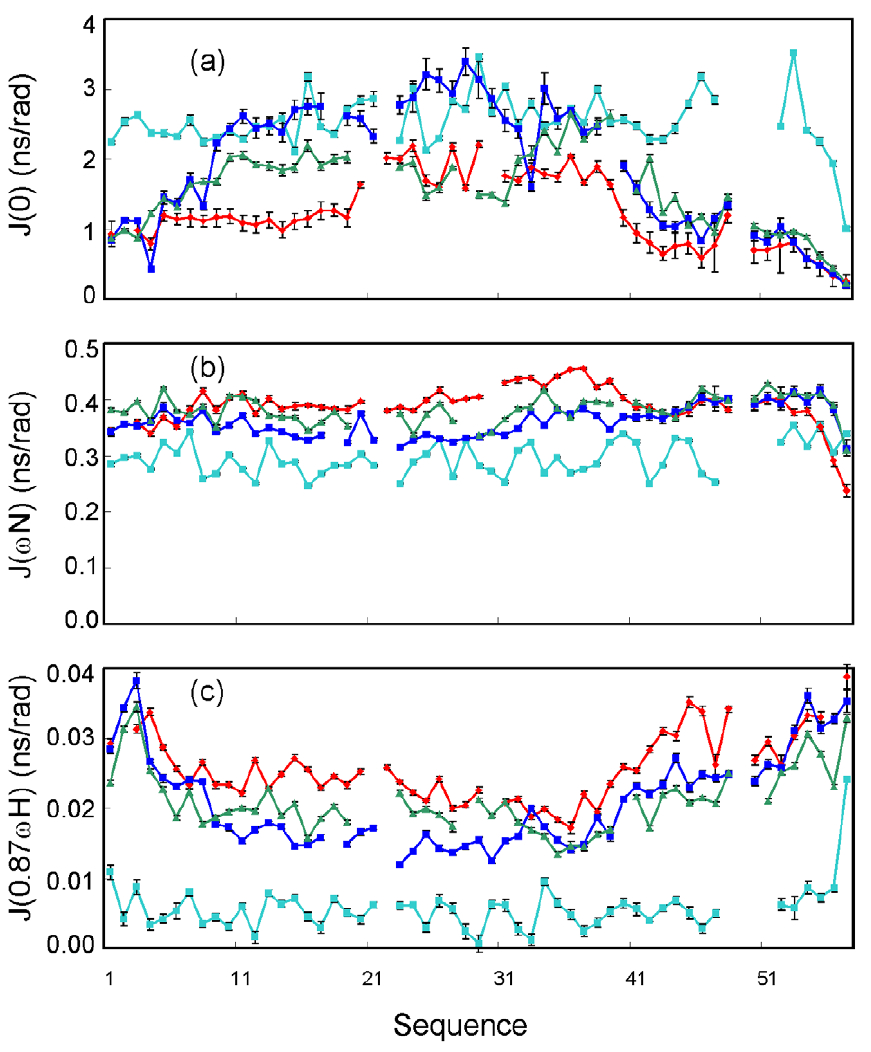
Figure 9. Reduced spectral density functions. Spectral densities of V22-SH3 solubilized in salt-free water at pH 4.0 (red); wild-type at pH 6.5 (cyan); wild-type at pH 2.0 (blue) and 4Ala mutant at pH 6.5 (green), calculated from the 15 N backbone relaxation data measured at 800 MHz. (a) J(0), (b) J( v N), and (c) J(0.87 v H).